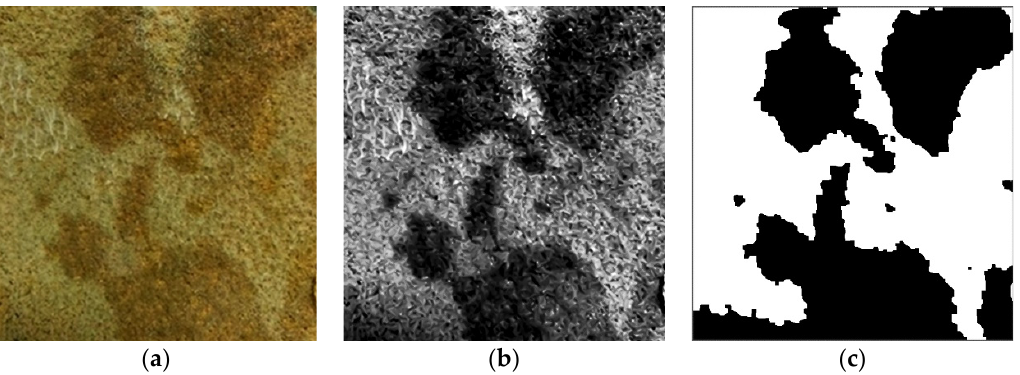
Figure 3. A specimen after 4 weeks: ( a ) Source image 40 × 40 mm; ( b ) monochromatic image before segmentation; ( c ) binary image, area of colonies: 44% of specimen.